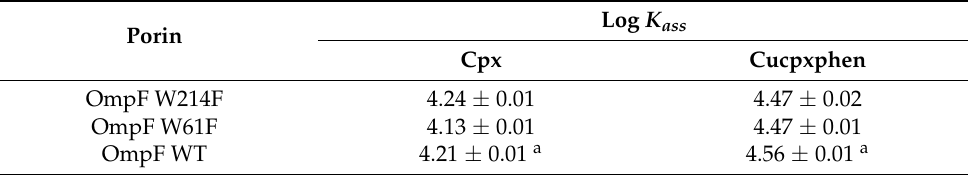
Table 4. Values of the association constants ( K ass ) of OmpF-compounds, determined with OmpF (W61F and W214F)/E. coli total extract proteoliposomes, by steady-state fluorescence, using Equa- tion (3). The presented values are the mean of, at least, three independent experiments ( ±